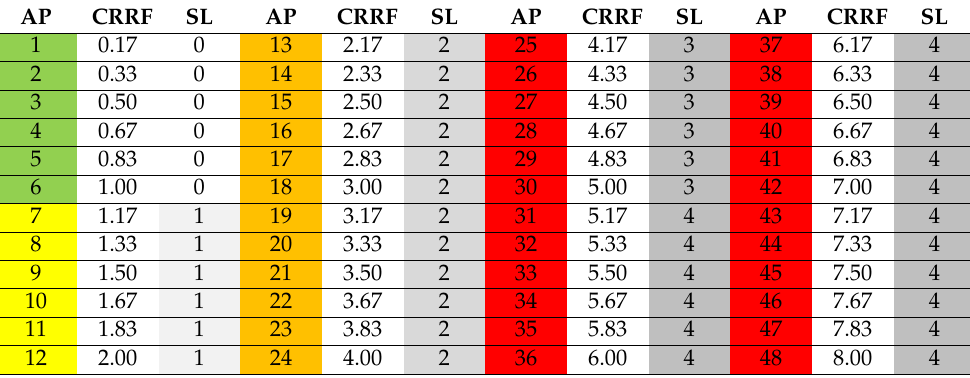
Table 16. Cybersecurity: AP value to SL mapping. AP CRRF